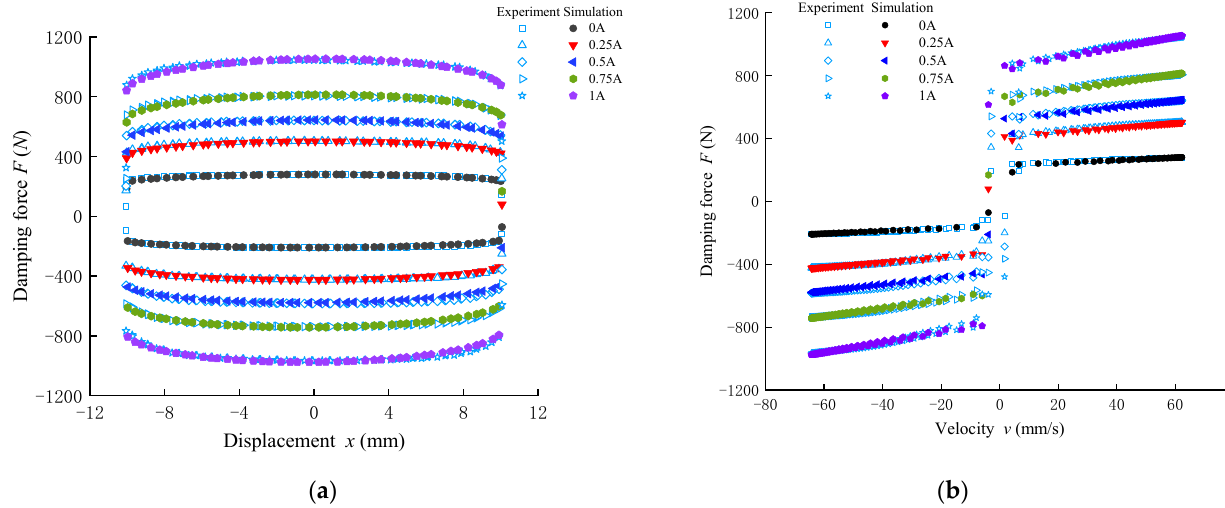
Figure 6. Comparison of simulation results and experimental tests. ( a ) Force displacement, and ( b ) force velocity.